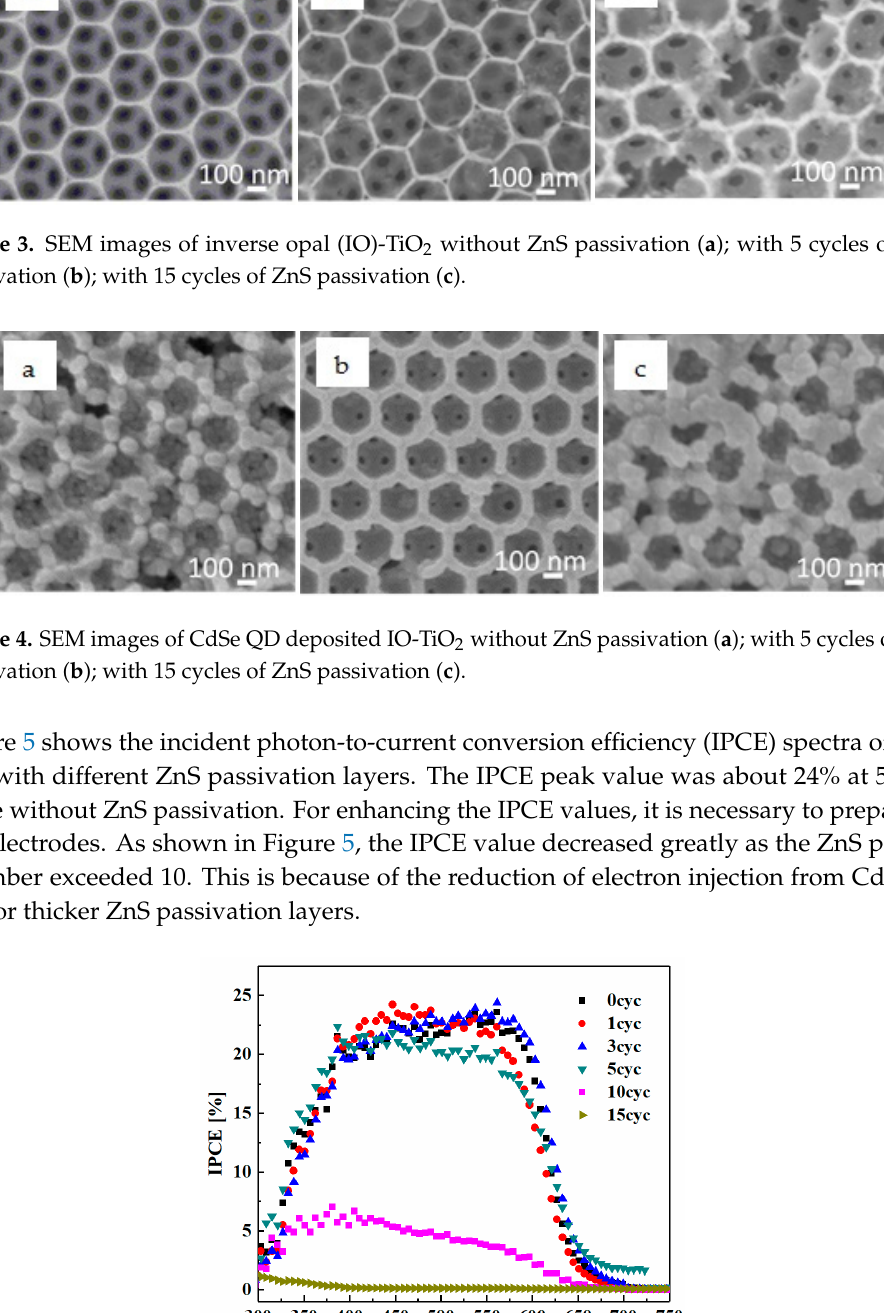
Figure 5. The incident photon-to-current conversion efficiency (IPCE) spectra for samples with different ZnS passivation layers.